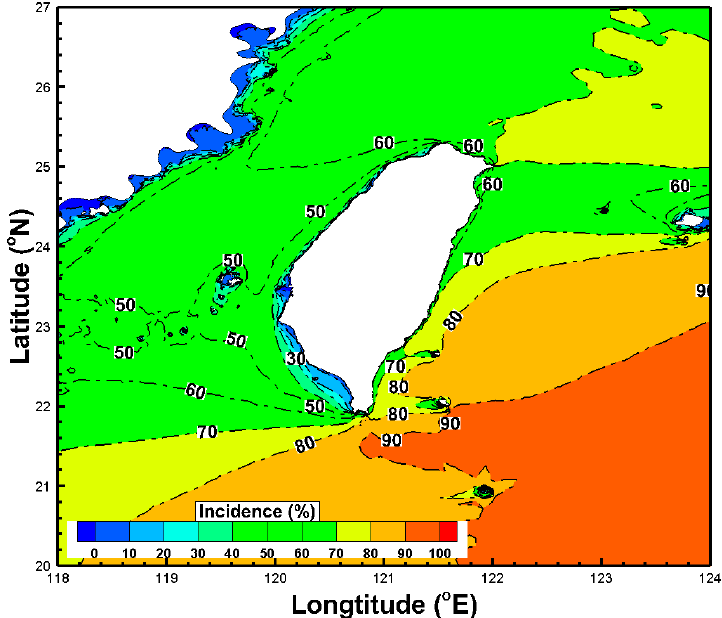
Figure 11. Spatial distribution of the incidence of the wave power exceeding 4 kW/m in the offshore waters of Taiwan averaged over 1991 to 2010.